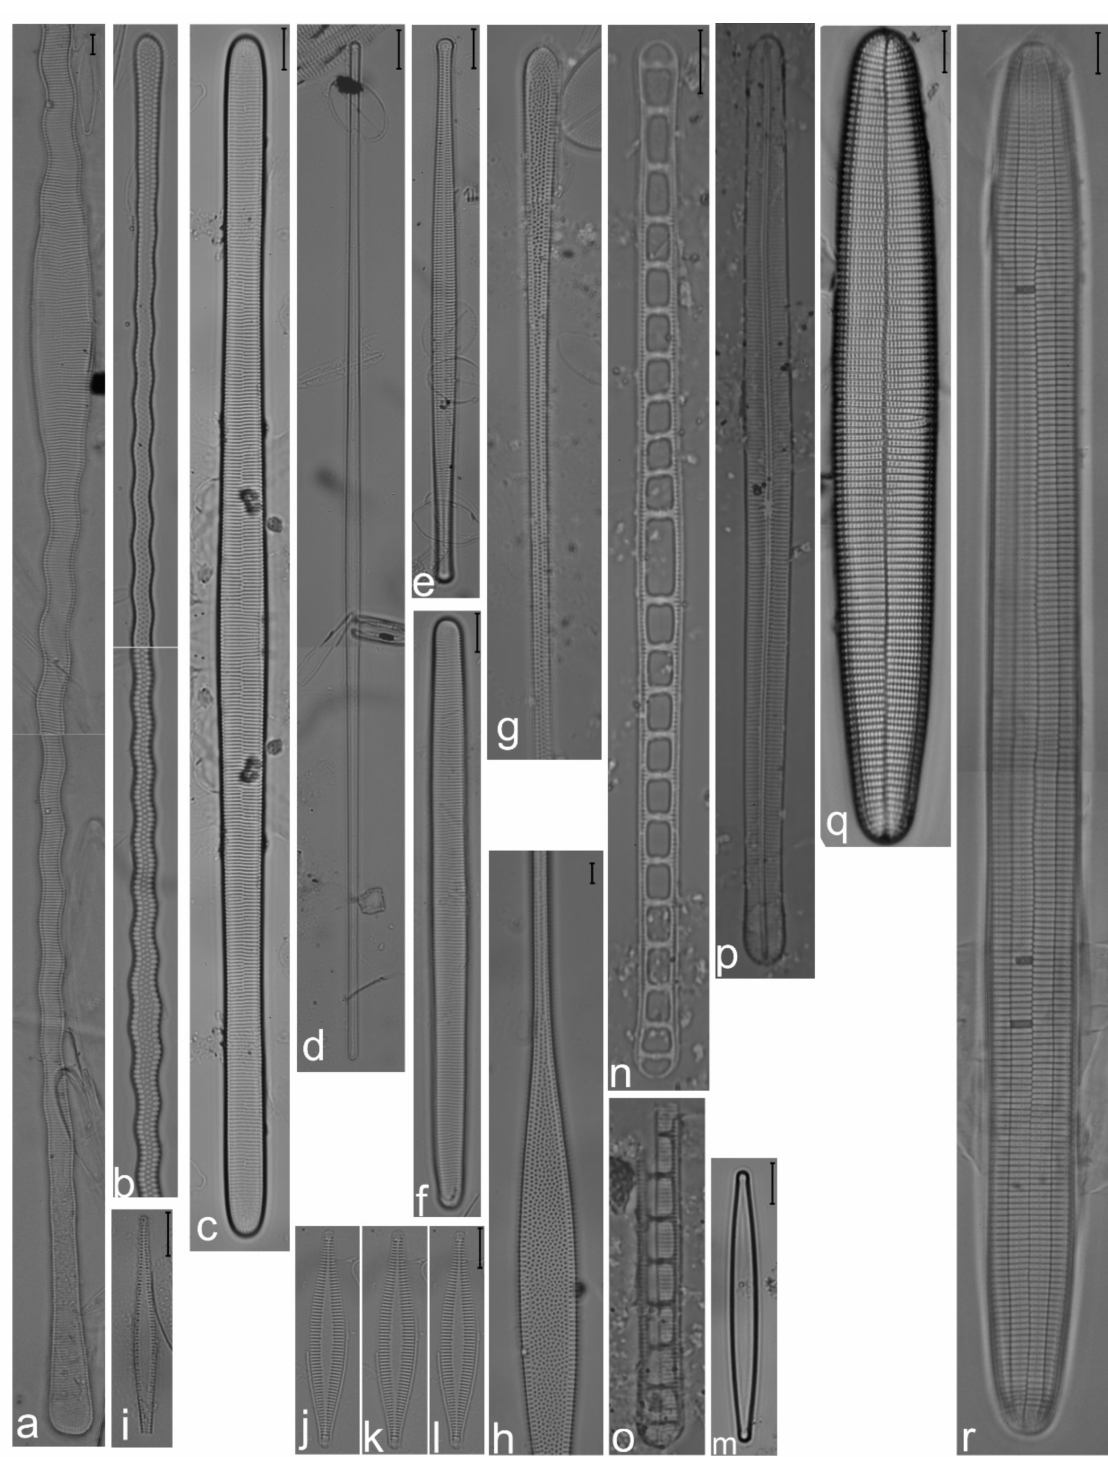
Figure 10. ( a , b ) Toxarium undulatum ; ( c , f ) Ardissonea fulgens ; ( e ) Fragilaria tenera ; ( g , h ) Toxarium hennedyanum ; ( i – l ) Tabularia fasciculata ; ( d , m ) Hyalosynedra laevigata ; ( n , o ) Climaconeis lorenzii ; ( p ) Berkeleya scopulorum ; ( q ) Synedra bacillaris ; ( r ) A . formosa . Scale bar = 10 µ